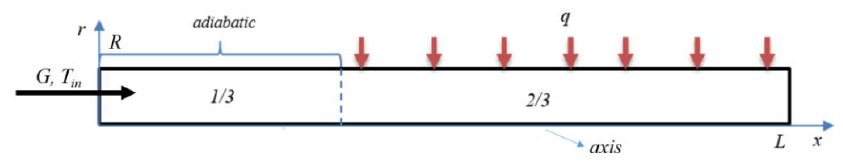
Figure A1. Schematic diagram of the 2D axisymmetric model.